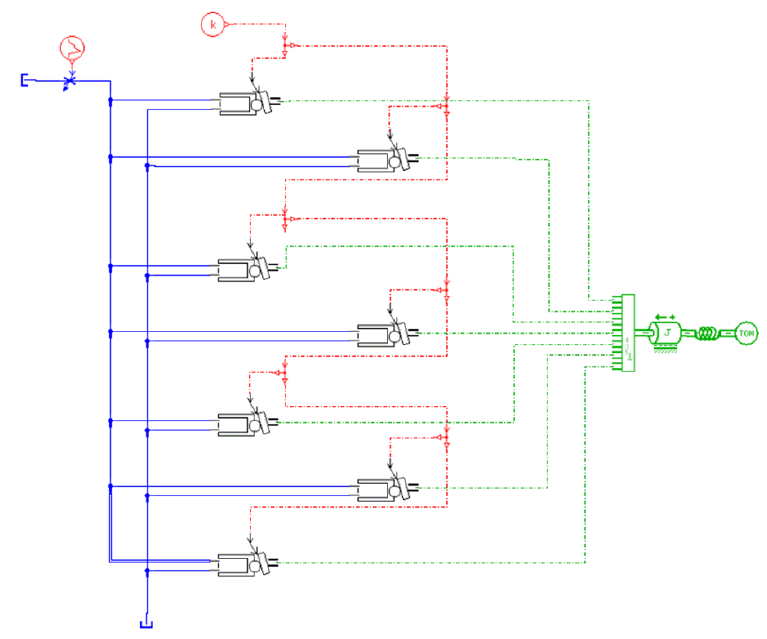
Figure 6. Overall model of the plunger pump.